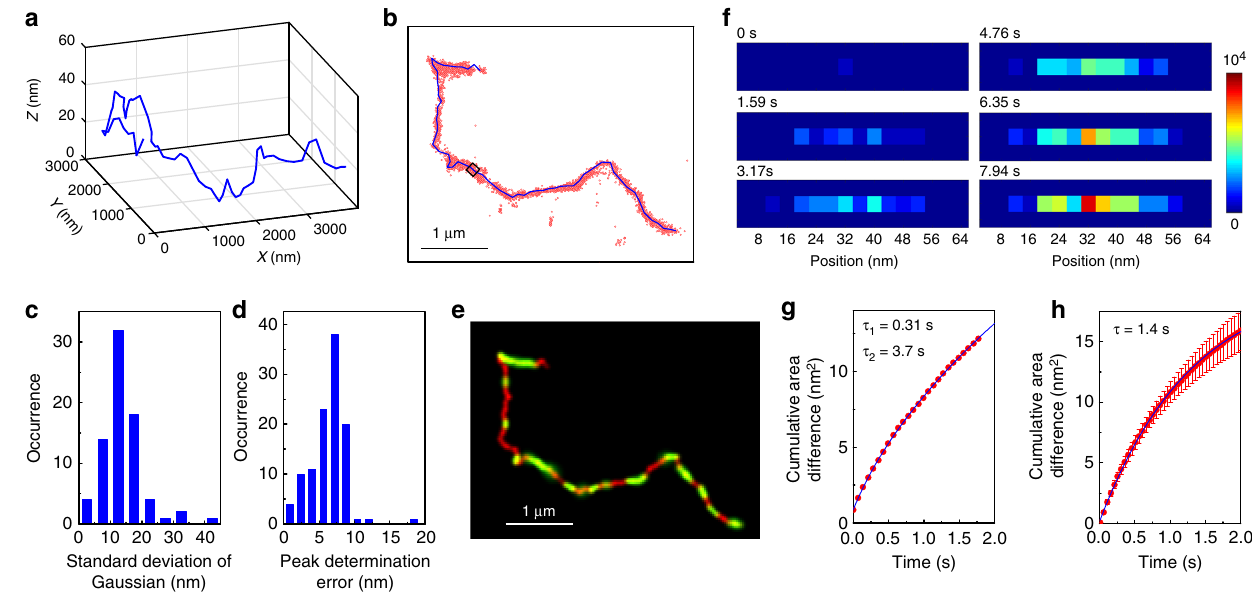
Fig. 3 Characterisation of local and global motion of single entangled DNA molecules. a 3D contour of the DNA molecule displayed in Fig. 2d. b 2D projected contour of the DNA molecule shown in a . The red dots show the localised spots determined in the super-resolution fl uorescence imaging experiment. The black square shows the region from which we obtained cumulative-area images displayed in f . c Frequency histogram of the standard deviation of Gaussian obtained by the fi tting of the local intensity pro fi les of the reconstructed super-resolution images at each segment. d Frequency histogram of peak determination error in the 1D Gaussian fi tting of the local intensity pro fi les of the reconstructed super-resolution images at each segment. e 2D projected contour of the DNA molecule displayed in Fig. 2c. The local widths of the contour correspond to the standard deviations of the Gaussian at each local segment. The regions that show standard deviation of the Gaussian smaller than that obtained from the super-resolution imaging of the surface-deposited molecule are shown in red, in which the width of the Gaussian is determined by localisation error rather than local motion of the molecule. f Cumulative-area images obtained from the local region shown in b at time 0, 1.59, 3.17, 4.76, 6.35, and 7.94 s. g Cumulative-area difference plots obtained from the local region shown in b (top). Characteristic times were calculated by fi tting the data to double-exponential function (solid line). h Mean cumulative-area difference plot obtained from 10 local segments of surface-deposited DNA molecules. Error bars correspond to the standard deviations. Characteristic time was calculated by fi tting the data to single-exponential function (solid ( M e ) of DNA is estimated to be between 9.4 and 23.1 kbp. The